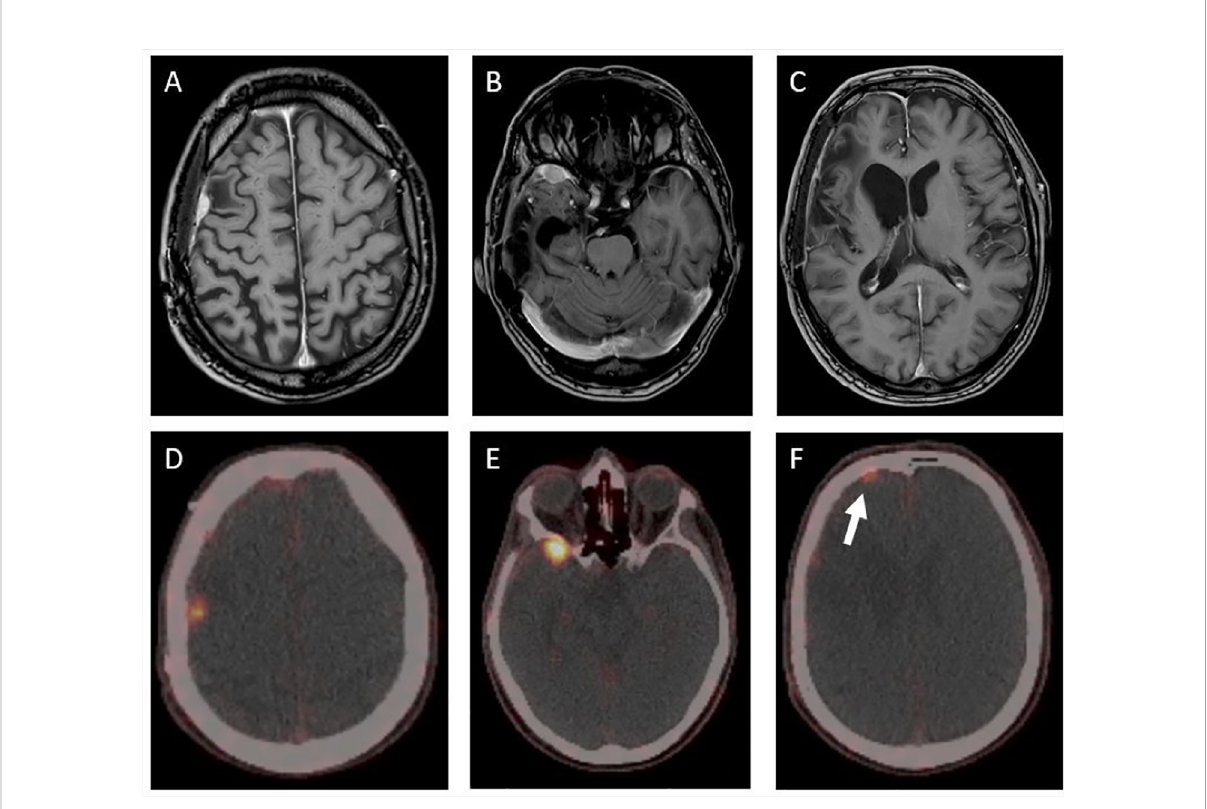
FIGURE 2 T1-contrast-enhanced MRI and 68 Ga-DOTATATE-PET/CT showing three PET-positive lesions in different locations (D – F) . The contrast- enhanced MRI (A – C) showed no clear correlate for the displayed PET-positive right frontopolar lesion (white arrow). The maximum standardized uptake value (SUV max ) was lower in the previously irradiated lesion (D) compared to those of the untreated lesions (E, F) (SUV max of 1.9 vs . SUV max of 9.8 and